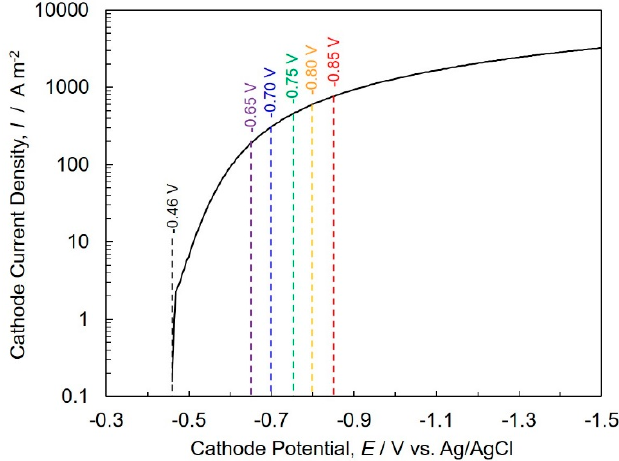
Figure 4. Cathode polarization curve for Co electrodeposition from an aqueous solution containing 0.5 M CoCl 2 and 0.4 M H 3 BO 3 . The solution temperature was kept at 60 °C.